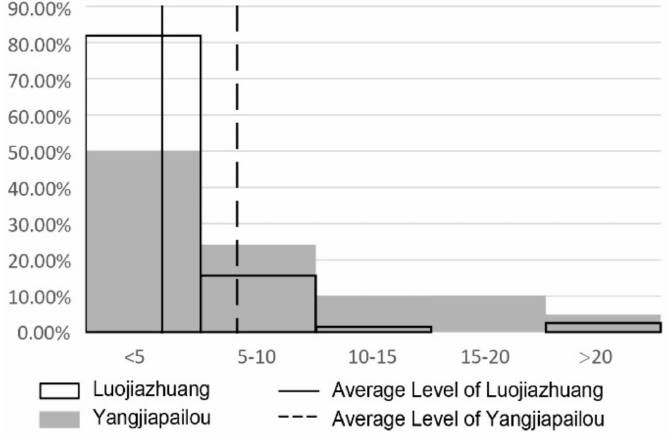
Figure 10. Business duration of side-street shops in Luojiazhuang and